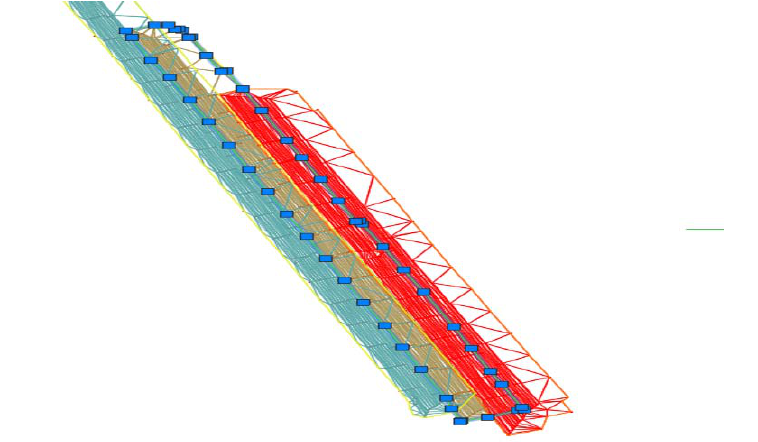
Figure 19 – Calculation boundaries for 2013 and 2014 Рис . 19 – Рубежи расчета 2013 г . и 2014 г . Слика 19 – Граница рачунања за 2013. и 2014. годину Also, the 2013 model is longer, so it is necessary to define the boundary of the volume calculation. This is accomplished by drawing 3D polylines connecting the peripheral excavation points from 2014 and adding the boundary in the toolbox, via the Boundaries option (Figure